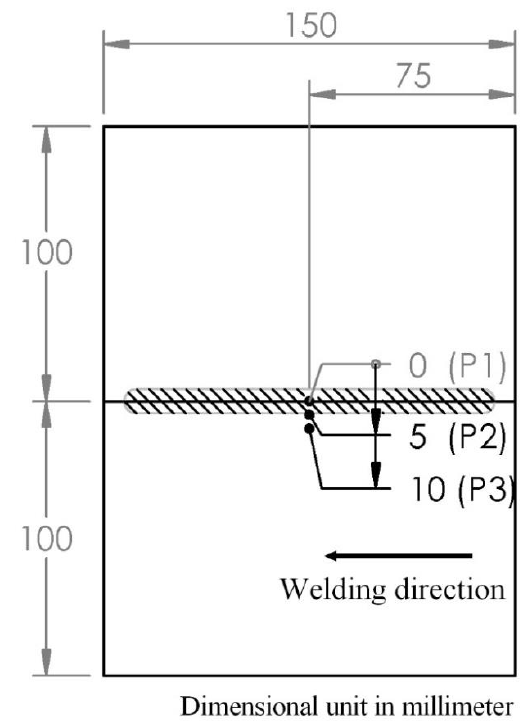
Figure 3. Position for measuring temperature. Table 4. Determining the level of factors used in the experiment.